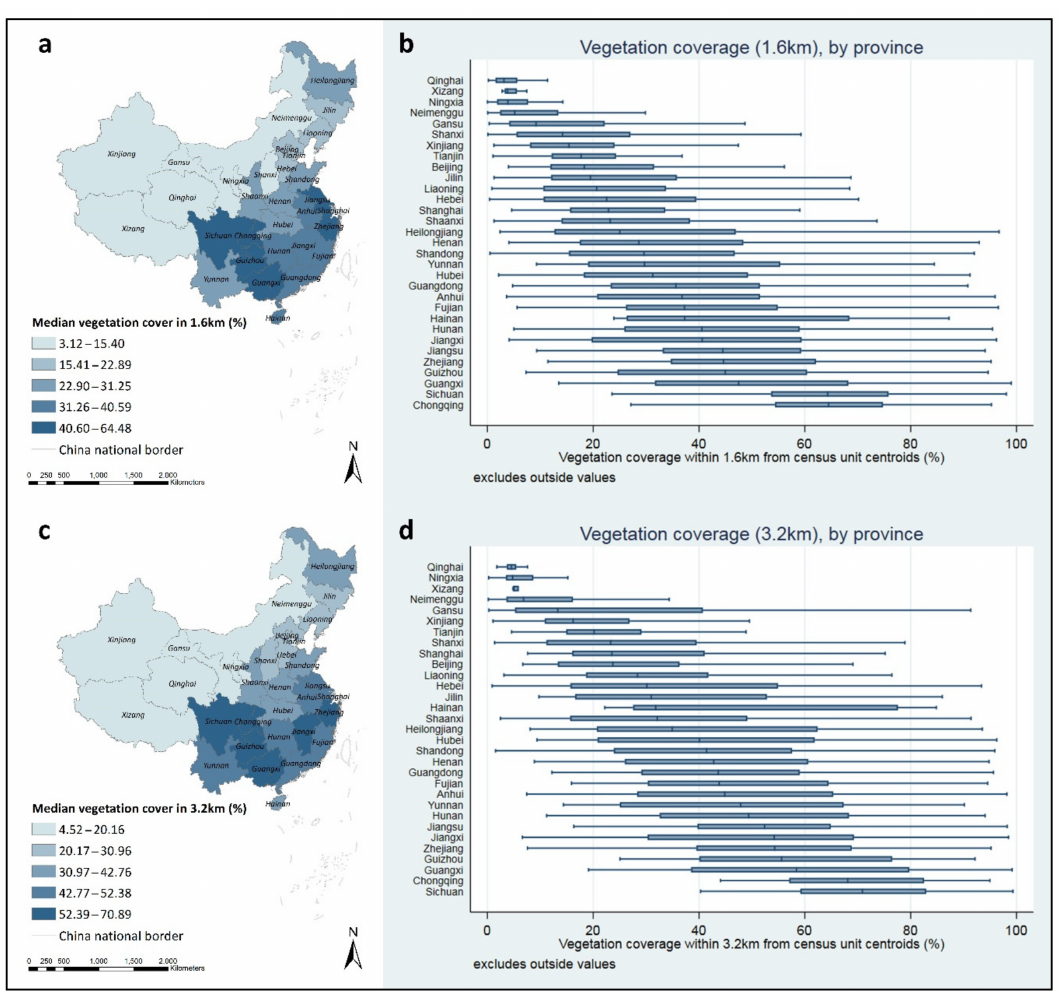
Figure 4. Provincial disparities of vegetation coverage ( a uses 1.6 km and c uses 3.2 km) and box plots of vegetation coverage by province ( b uses 1.6 km and d uses 3.2